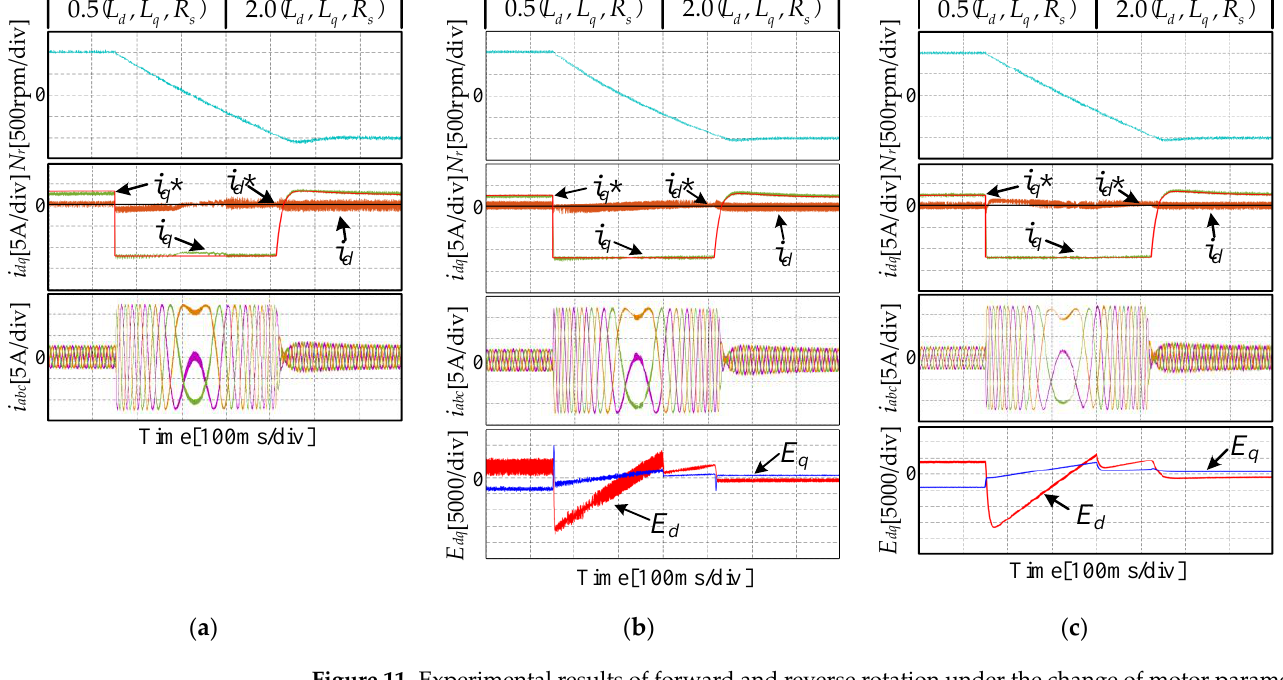
under the motor parameters change. The specific working condition is that the motor speed changes from 1000 rpm to − 1000 rpm with a load of 5 N · m. The motor parameters change from 0.5*( L d , L q , R s ) to 2.0*( L d , L q , R s ). It can be seen that the current of MPCC and CMFPCC has a large error during forward and reverse rotation when the parameters are not matched. In contrast, the dynamic waveform of IMFPCC is smooth and has less error.